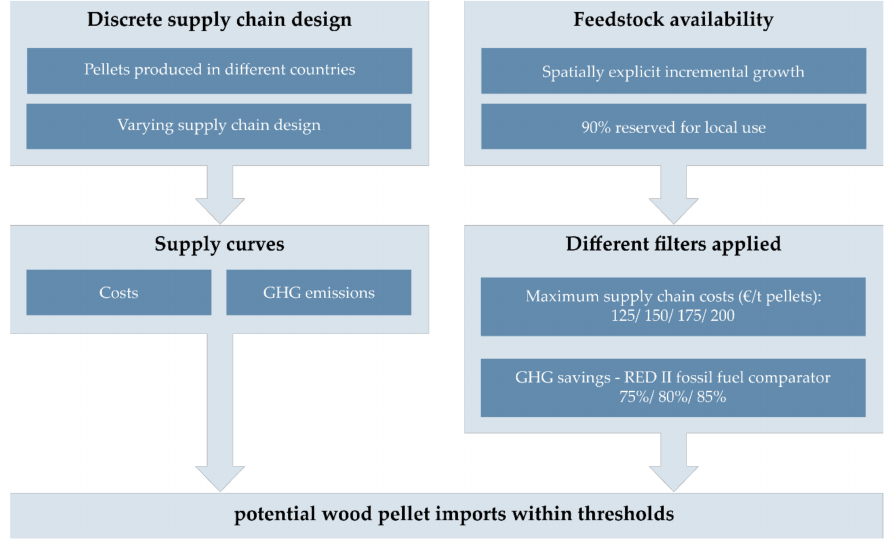
Figure 1. General research